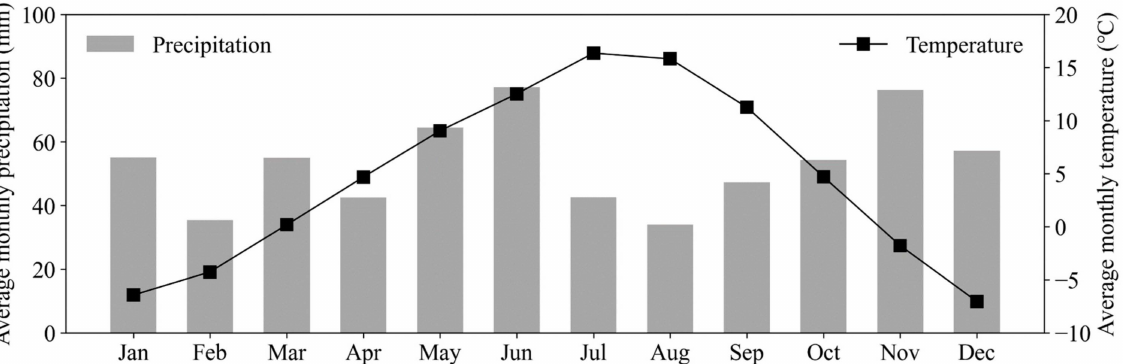
Figure 2. The average monthly precipitation and the average monthly temperature between 1990 and 2013 at the case study mine.